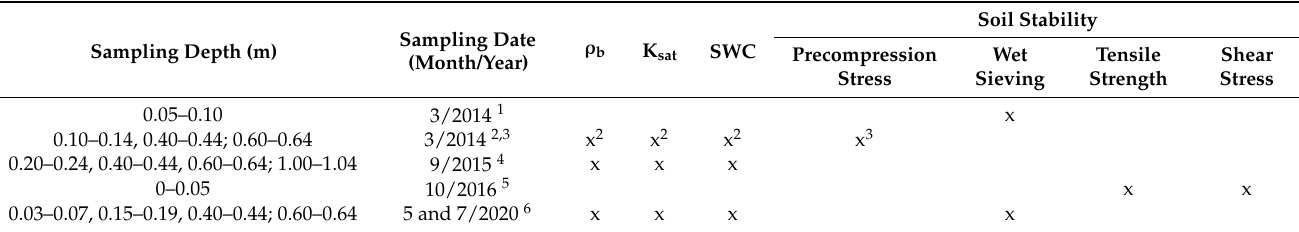
Table 1. Soil physical measurements conducted in the LTE